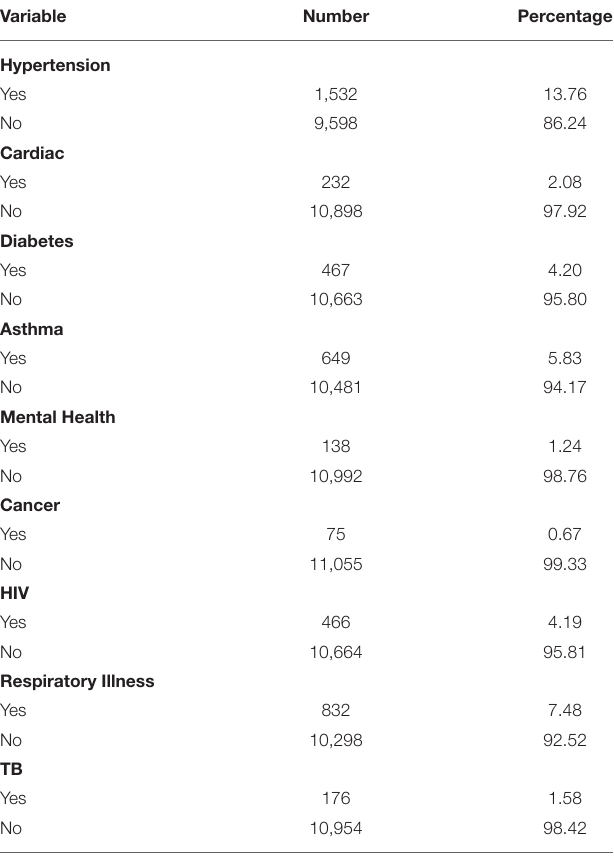
TABLE 2 | Any household member with the following conditions ( N = 11,130).